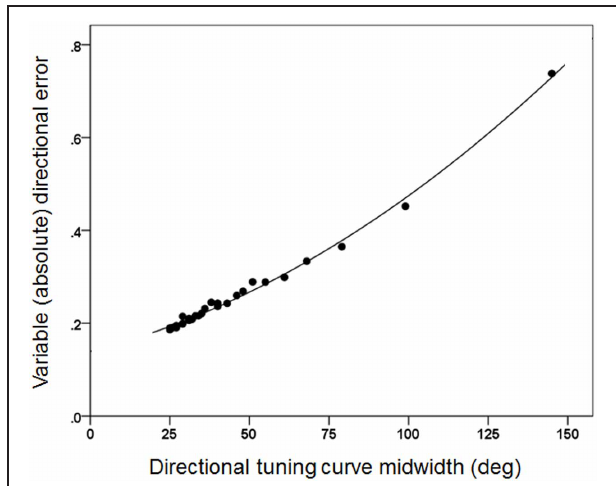
FIGURE 4 | The same variable error as in Figure 3 is plotted against the directional tuning curve midwidth. The fitted line is a quadratic fit ( R 2 = 0 .